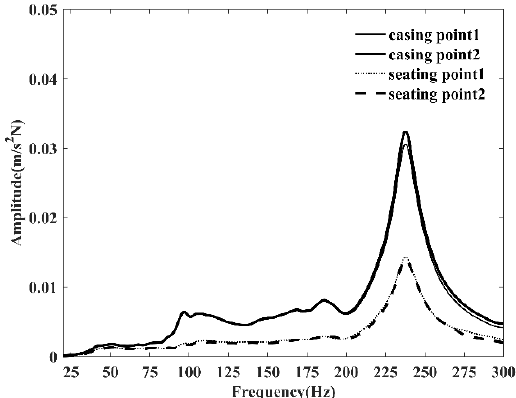
Figure 10. Measured AFRF of thrust bearing without friction damper.